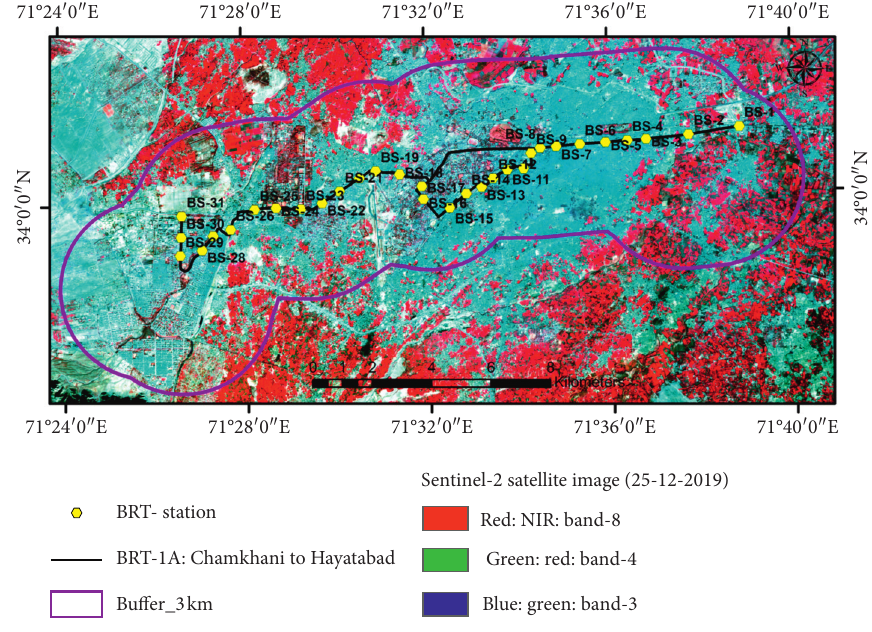
Figure 1: Peshawar City settlement overlaid with BRT station and route